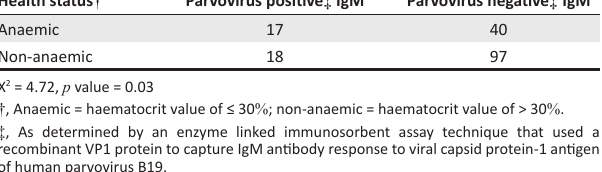
percentage of anaemic participants ( n = 40; 70.2 % ) were negative for parvovirus B19 infection. Overall, 97 (84.4 % ) participants had no anaemia and no parvovirus B19 infection.